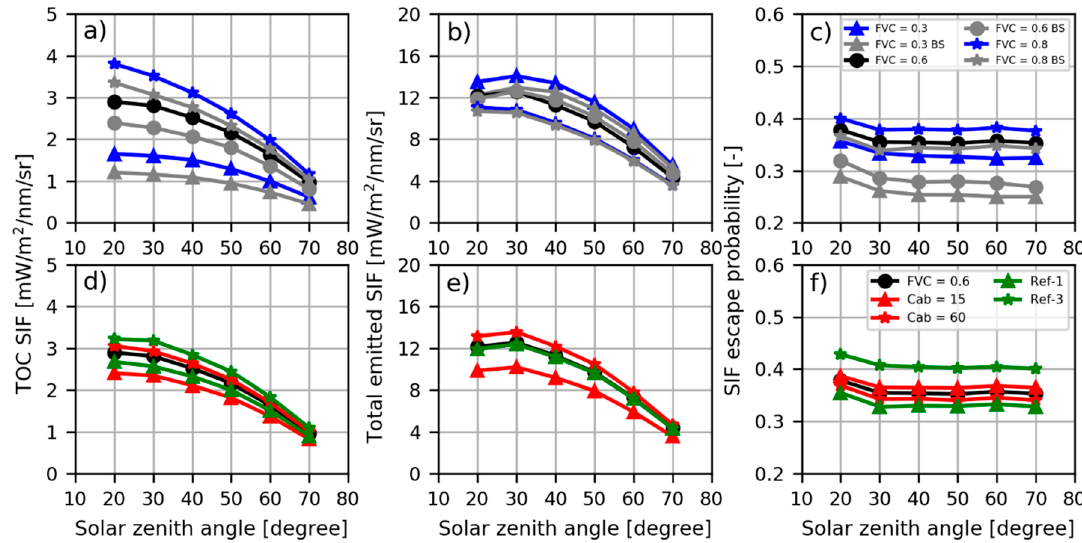
Figure 2. DART-simulated Top of Canopy (TOC) SIF ( a , d ), total emitted SIF ( b , e ), and corresponding SIF escape probabilities ( c , f ). BS means black soil (i.e., non-reflecting background). The label - • - indicates the default configuration (fractional vegetation cover (FVC) = 0.6, chlorophyll content (Cab) = 35 µ g / cm 2 , Ref-2). The top row refers to varying canopy structure, and the bottom row refers to variable leaf and background spectral properties.